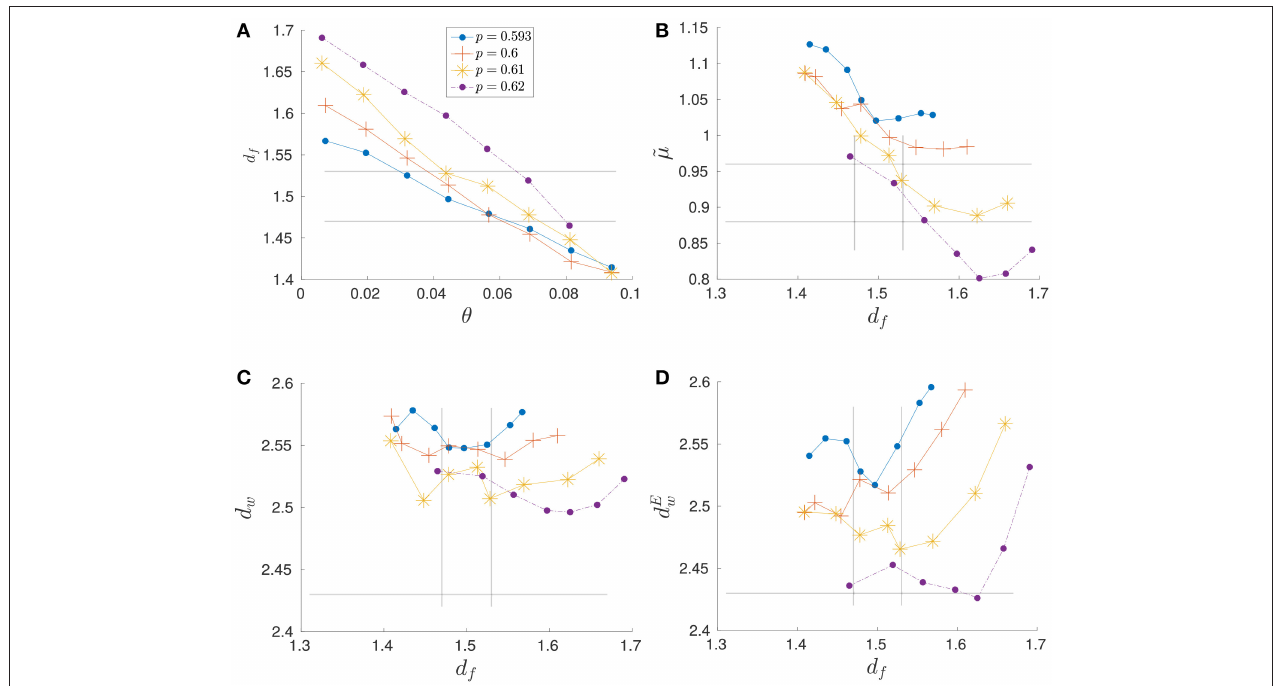
FIGURE 5 | (A) Fractal dimension d f , (B) conductivity exponent ˜ µ , (C) walk exponent d w , and (D) walk exponent computed using the Einstein relation d E w of θ -subnetworks of percolation clusters generated using threshold probabilities p = p c = 0.593, p = 0.60, p = 0.61, and p = 0.62. Zones delimited by lines represents exponents, with the error intervals, of observed karst networks ( Table 1 ). In (C,D) only the upper allowed value of d w is represented by a line.